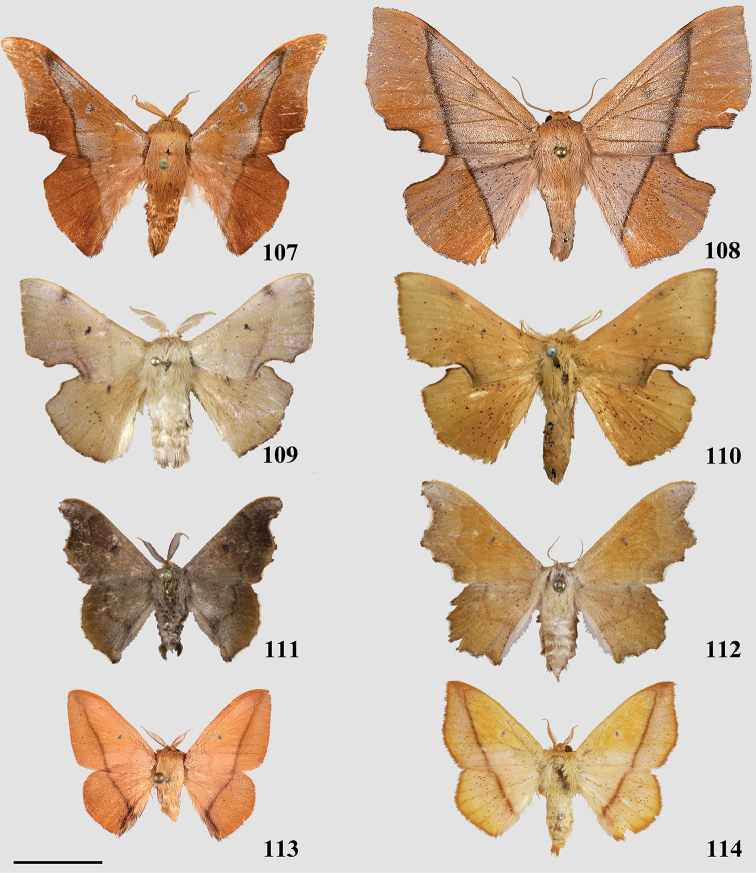
Adult specimens of type species of genera belonging to Lacosominae: Trogopterini and Lacosomini. 107Reinmaraenthona, male [reused with permission from St Laurent et al. (2017c), ZooKeys] (CDH) 108R.enthona, female [reused with permission from St Laurent et al. (2017c), ZooKeys] (CDH) 109Trogopteracfnotata, male (MGCL) 110Trogoptera sp., female (NHMUK) 111Lacosomachiridota, male (MGCL) 112L.chiridota, female (MGCL) 113Vanengamera, male [reused with permission from St Laurent and Herbin (2017), ZooKeys] (CDH) 114V.mera, female [reused with permission from St Laurent and Herbin (2017), ZooKeys] (CUIC). Scale bar: 1 cm.